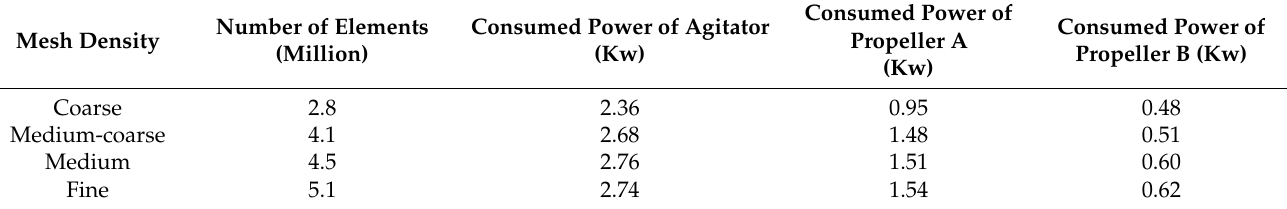
Table 1. Analysis of power consumption with mesh density.